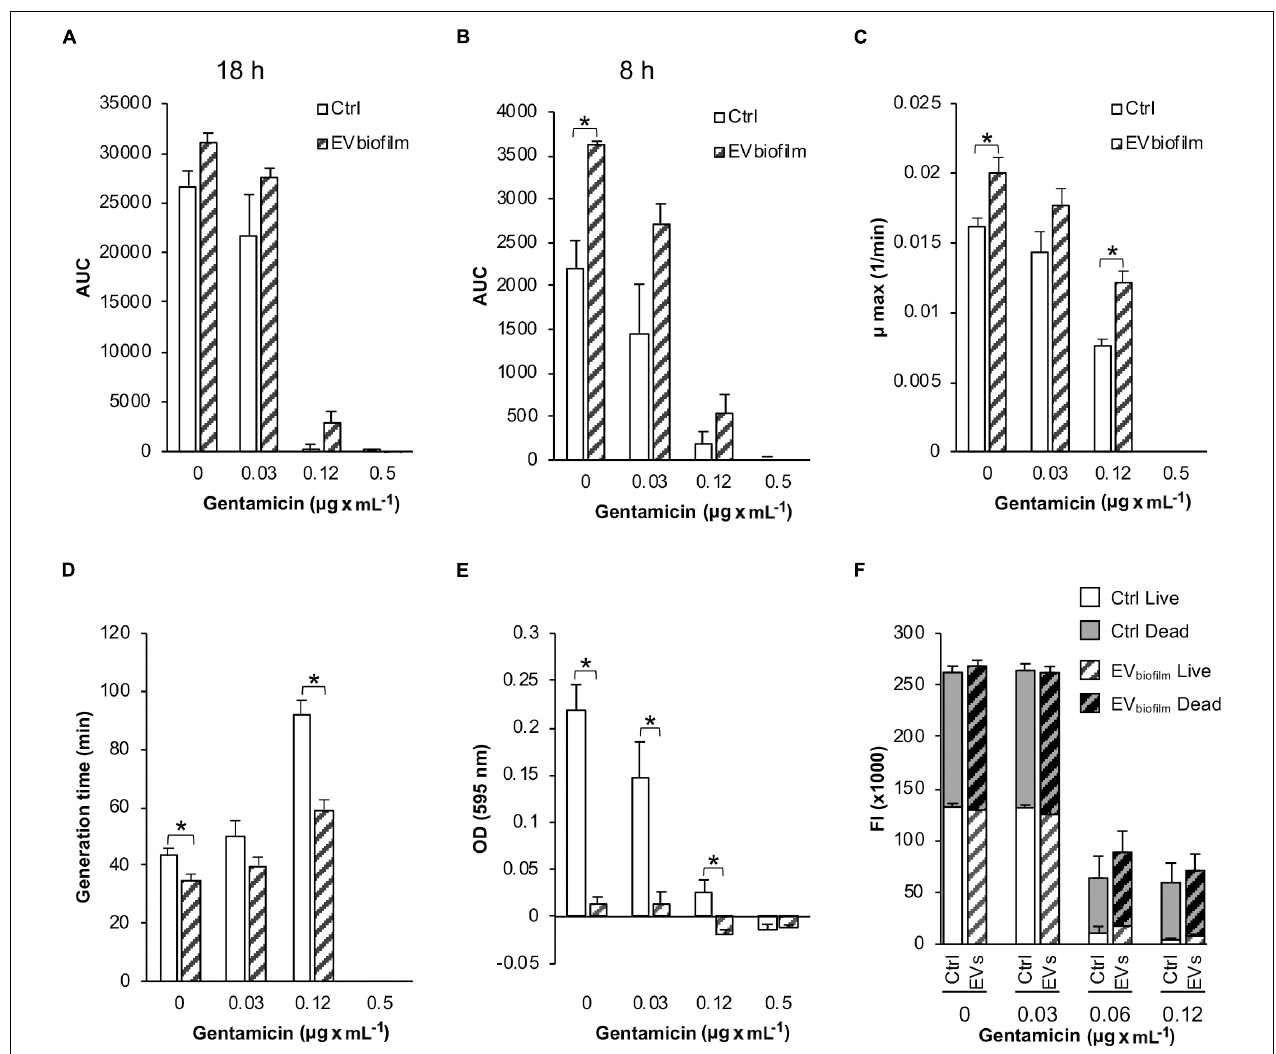
FIGURE 7 | Bacterial growth, cell adhesion, and viability of the biofilm neg /GEN S Staphylococcus epidermidis CCUG 64523 upon stimulation with EVs derived from the biofilm pos /GEN R strain S. epidermidis ATCC 35984 (EV biofilm ). The total growth was calculated as the AUC after (A) 18 h of culture and (B) 8 h of culture. (C) The maximum growth rates. (D) Generation times. (E) Cell adhesion as measured by the microtiter plate assay. (F) Live/dead fluorescence measurements of viability of the planktonic population. Gray background bars (top) represent the dead population, and white background bars (bottom) represent the live population. The data represent the mean ± SEM ( n = 3); * indicates a significant difference compared to the Ctrl with p <